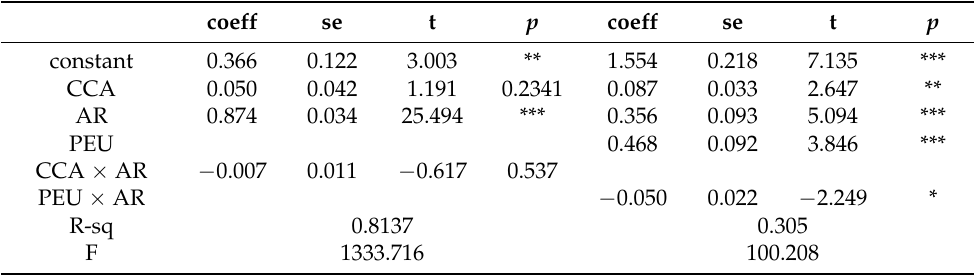
Table 8. Test of moderating effect with PEU as mediating